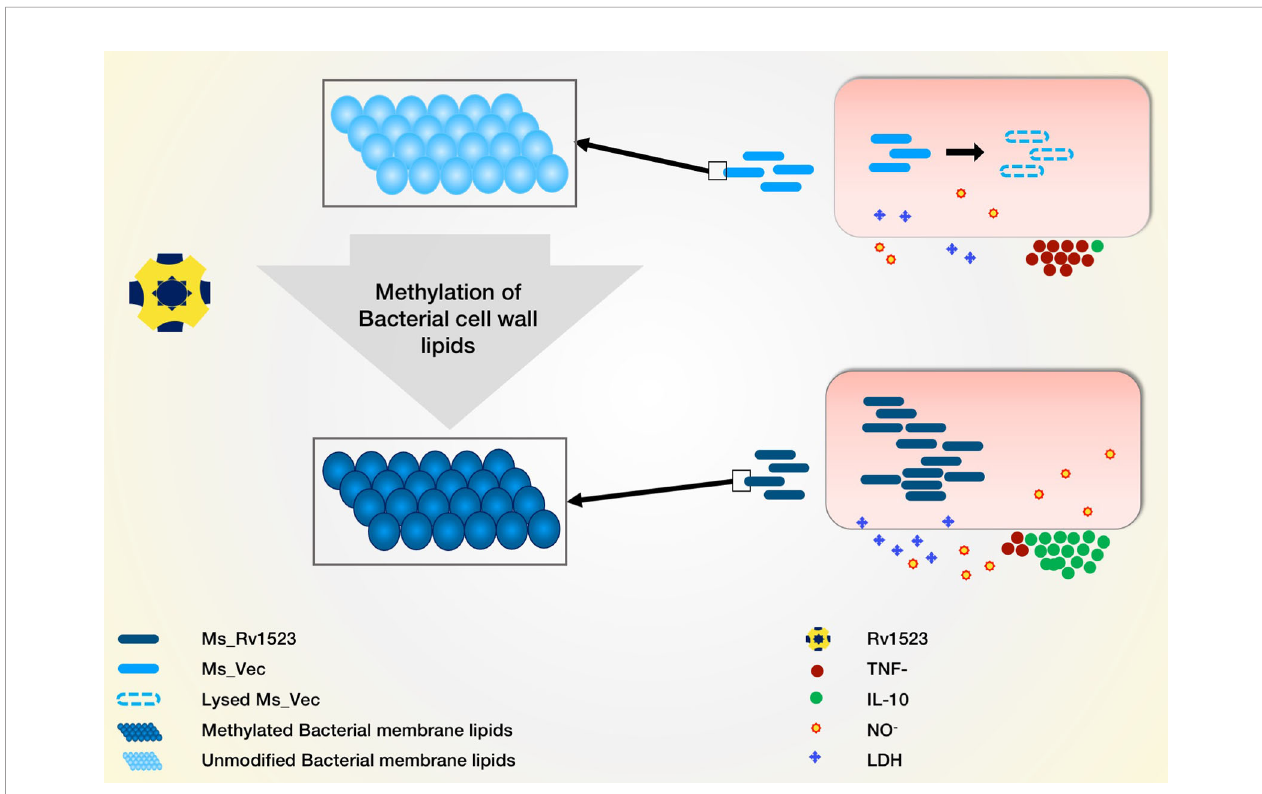
FIGURE 7 | Model depicting the role of Rv1523 in bacterial cell wall lipid modulation and macrophages immune response alteration. We predict the role of Rv1523 methyltransferase in cell wall lipid modulation. Recombinant M. smegmatis expressing Rv1523 (Ms_Rv1523) displayed higher survival in macrophages as compared to M. smegmatis not expressing Rv1523 (Ms_Vec). Ms_Rv1523 induced increased expression of anti-in fl ammatory cytokine IL-10 and reduced the expression of proin fl ammatory TNF- a